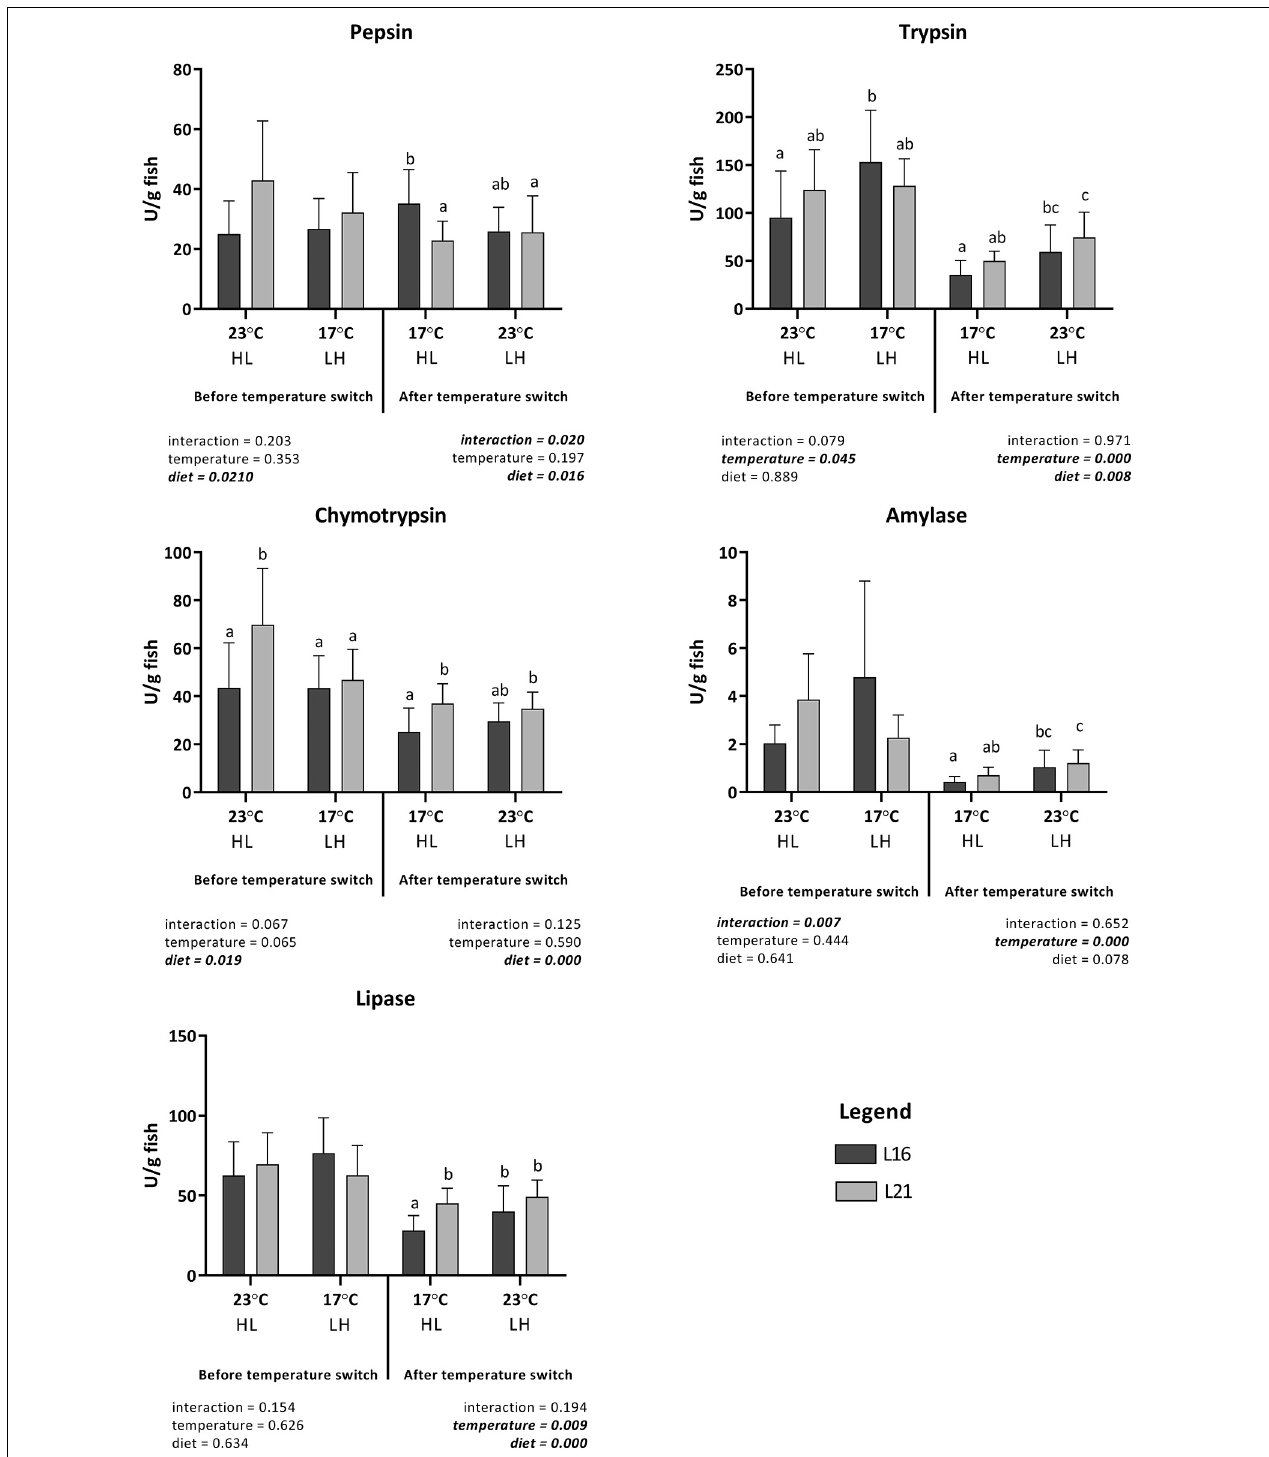
FIGURE 1 | Digestive gut enzymes activity (expressed as U g fish body weight - 1 ) of gilthead sea bream fed the experimental diets and exposed to temperature switch over 121 days. Data are given as the mean of triplicate tank individual samples ( n = 3 per tank before temperature change, n = 5 per tank after temperature change) ± SD. Different letters indicate significant difference (two-way ANOVA P ≤ 0.05) between treatments. L16, low-lipid 16% diet; L21, high-lipid 21% diet. HL, constant temperature exposure to high (H) 23 ◦ C until temperature switch (days 0–58), then to constant low (L) 17 ◦ C until end of trial (day 59–21); LH, constant temperature exposure to low (L) 17 ◦ C until temperature switch (days 0–58), then to constant high (H) 23 ◦ C until end of trial (day 59–121).